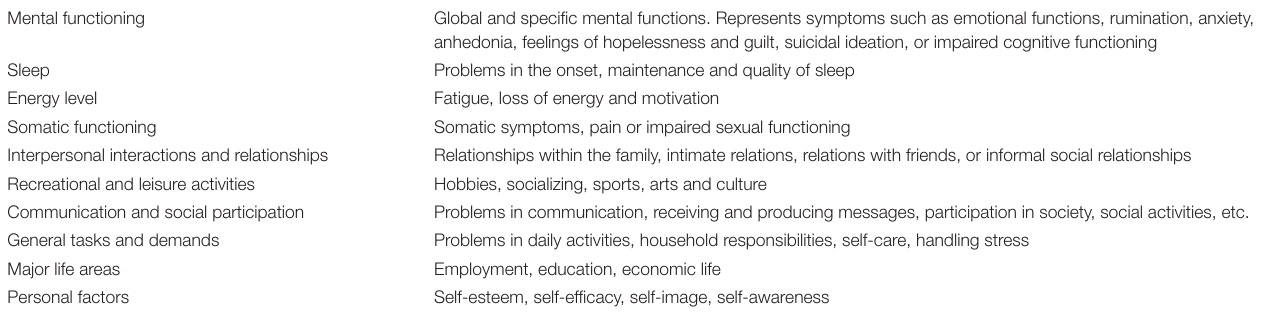
TABLE 3 | Functioning areas identified for inclusion in the measurement of treatment